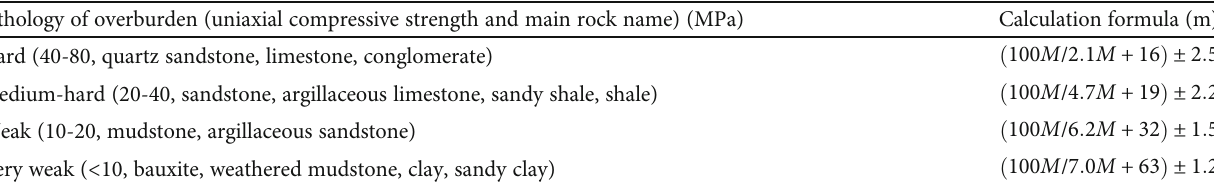
Table 3: Empirical formula for calculating the height of caving zone.